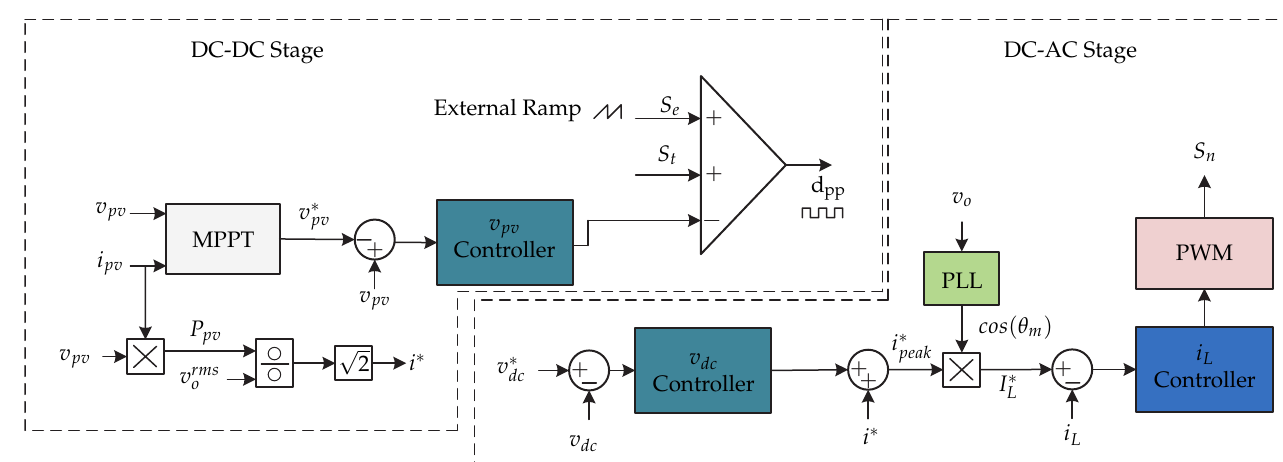
Figure 39. Control strategy proposed in [74–76].